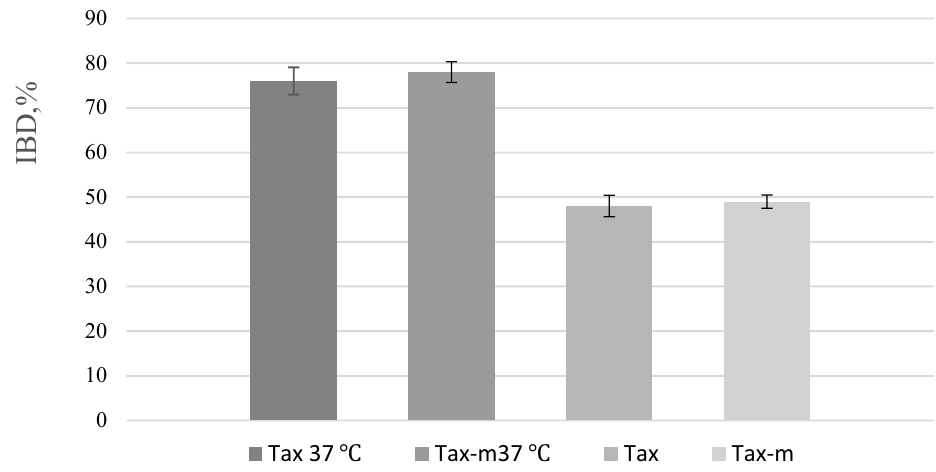
Figure 7. Digestion of taxifolin in the gastrointestinal tract in vitro. Encapsulation into yeast cells provided a protective effect for taxifolin, with a loss of 22–24%. Mechanically, it seems likely that taxifolin is bound to the hydrophobic regions of the biopolymers located within the cellular structures and protected by the cell wall,